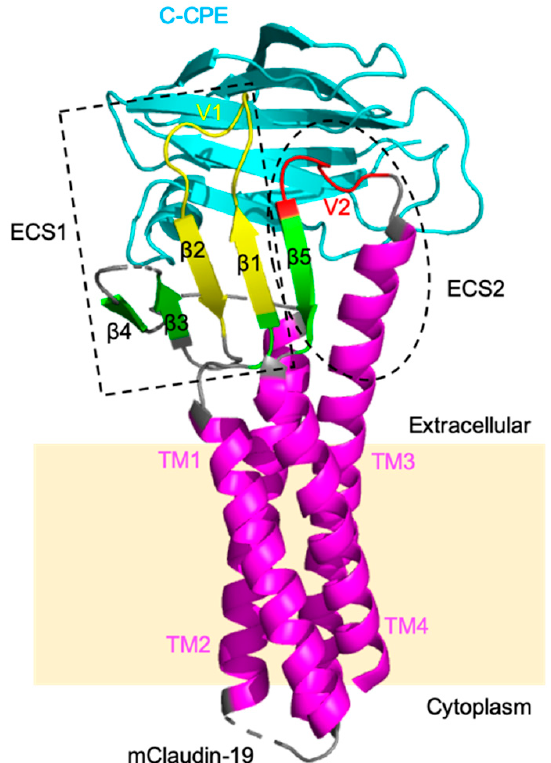
Figure 4. Structure of mouse claudin-19 in complex with C-terminal Clostridium perfringens enterotoxin (C-CPE) (Protein Data Bank (PDB): 3X29) [80]. Mouse claudin-19 has four transmembrane helices (TM1–TM4) (pink) and two extracellular segments (ECS)1 (dashed square) and ECS2 (dashed circle). The variable regions of (V)1 and V2 are displayed in yellow and red, respectively. C-CPE is